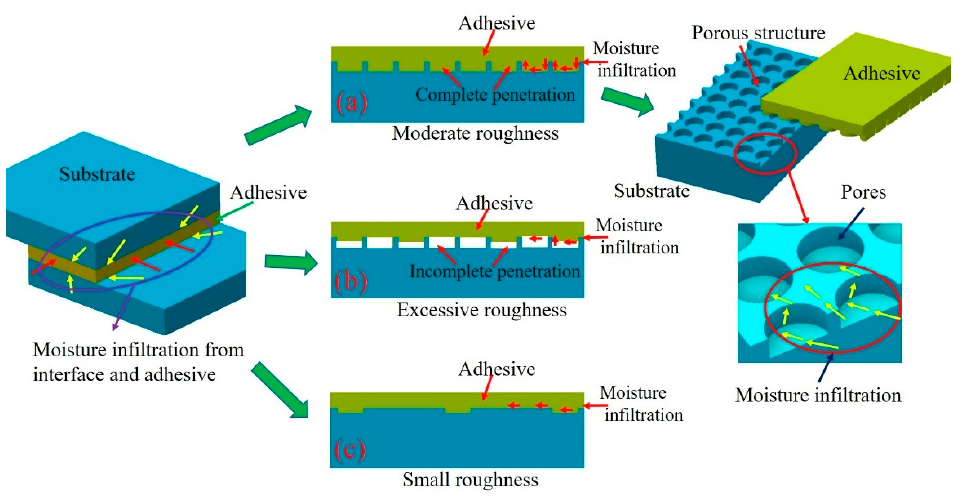
Figure 15. Schematic of moisture infiltration process in different bonding interfaces: ( a ) moderate roughness, ( b ) excessive roughness, and ( c ) small roughness.